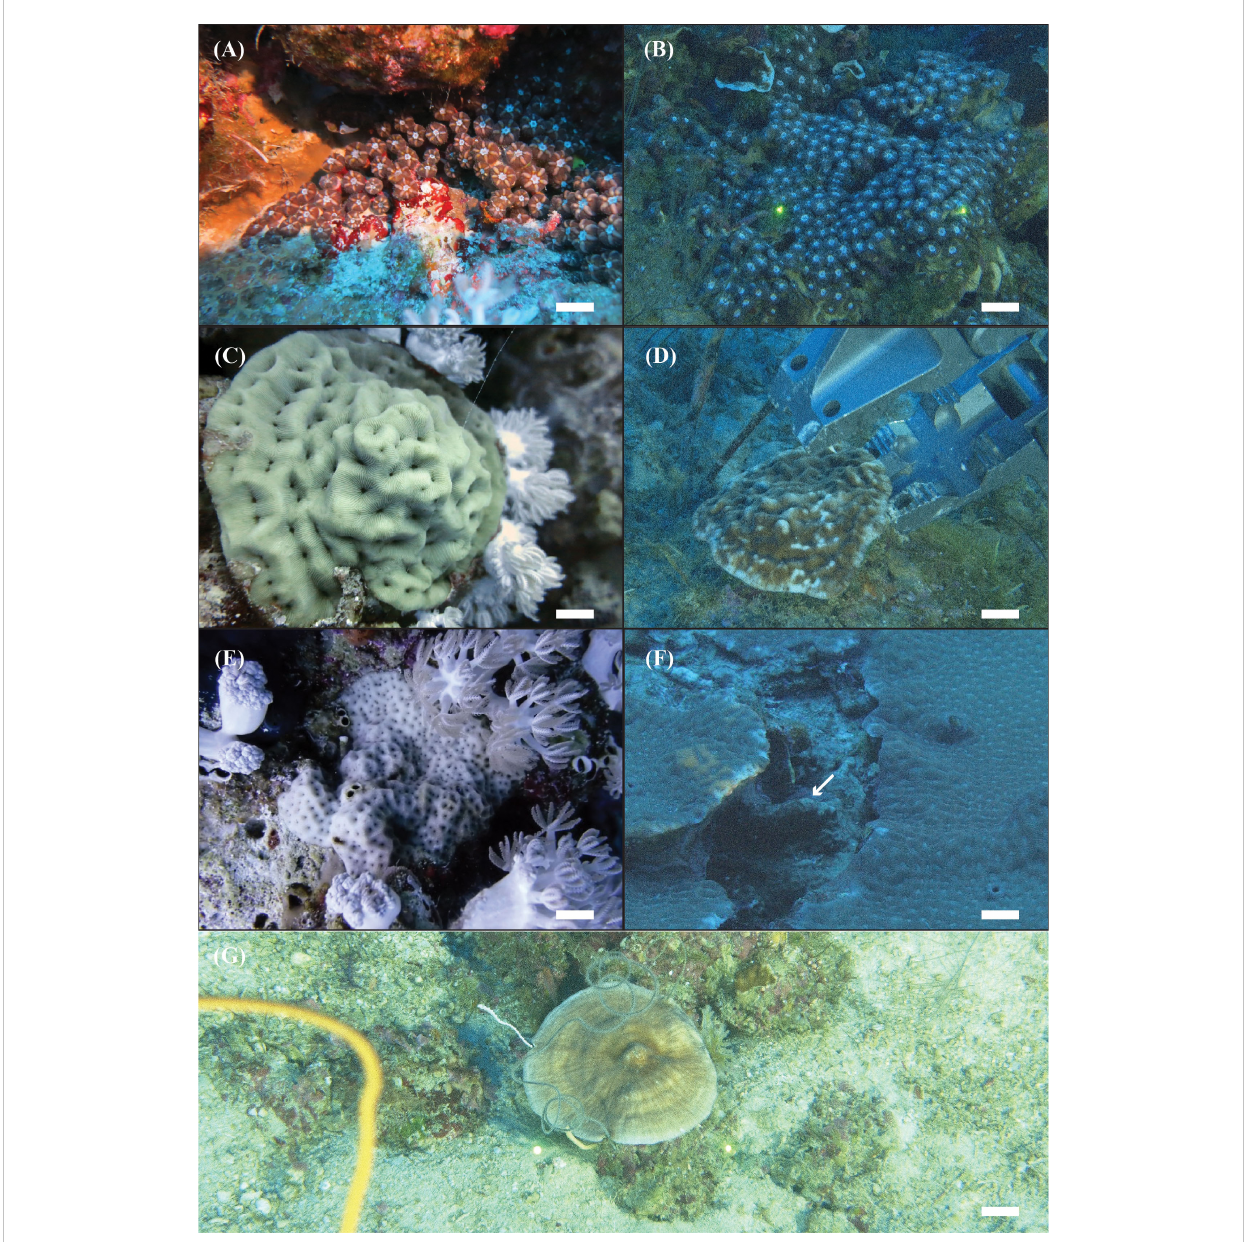
(F) NTN0048-14B — mesophotic . Craterastrea levis : (G) NTN0043-20 —